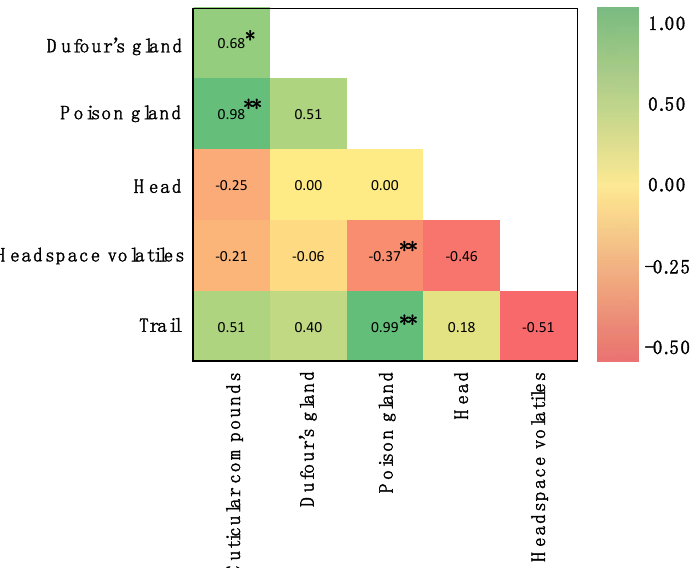
Figure 2. Multivariant correlation analysis of compounds isolated from different body parts, headspace, and trails of Oecophylla smaragdina . Analysis was based on the concentration and presence/absence of compounds . Pearson R value and P value were used as benchmark to determine the origin of compounds. Significance is denoted by * (<0.01); ** (<0.001).